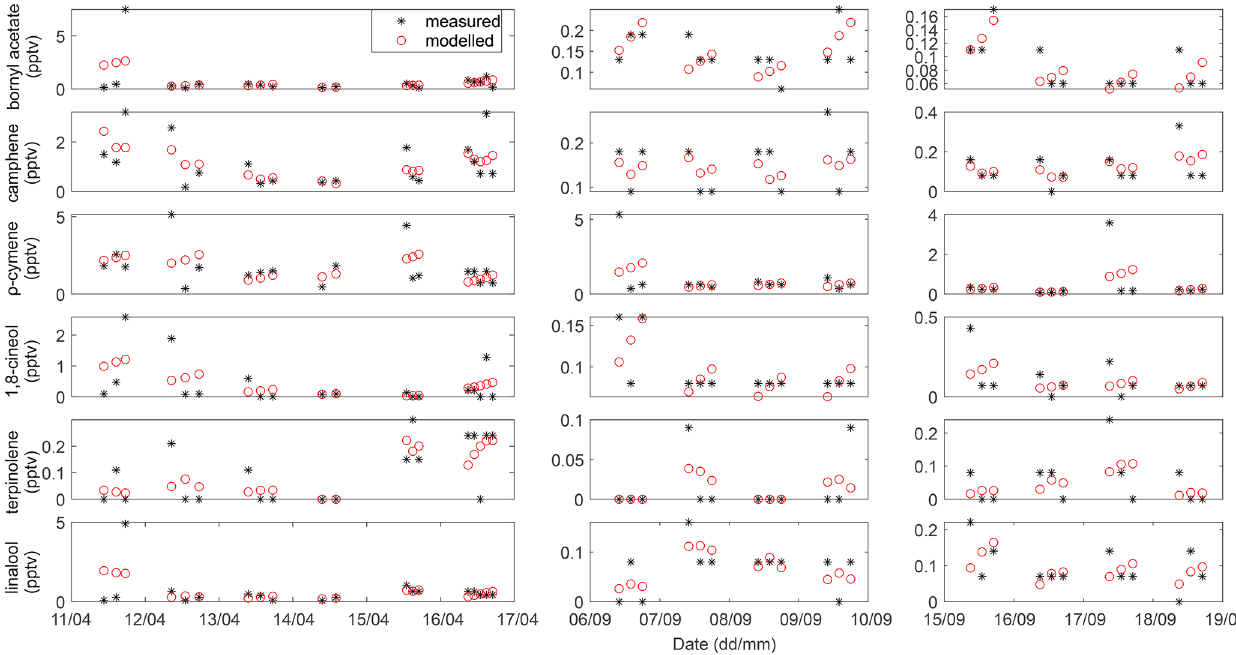
Figure A2. Measured and modeled mixing ratios of BVOCs.